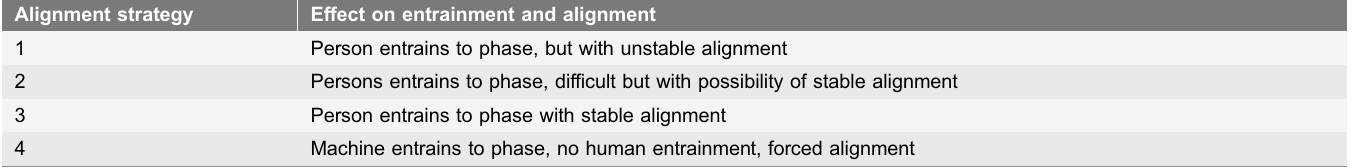
Table 7. Effect of strategy on entrainment and alignment. Alignment